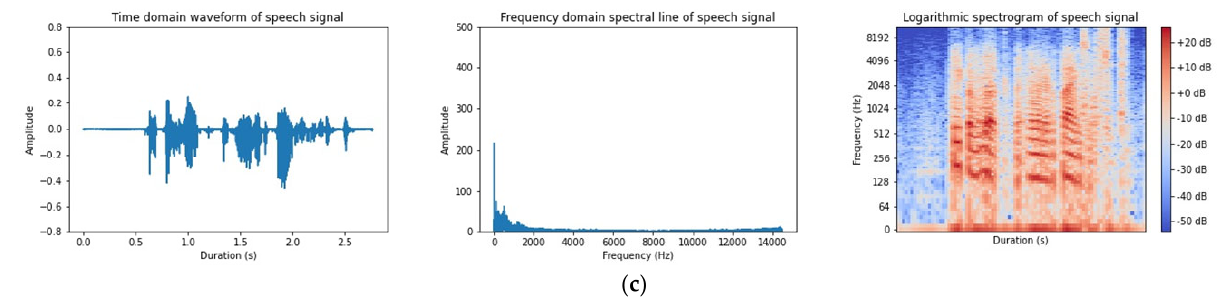
Figure 7. Comparison of speech enhancement samples: ( a ) noise; ( b ) clean; and ( c ) MANNER.